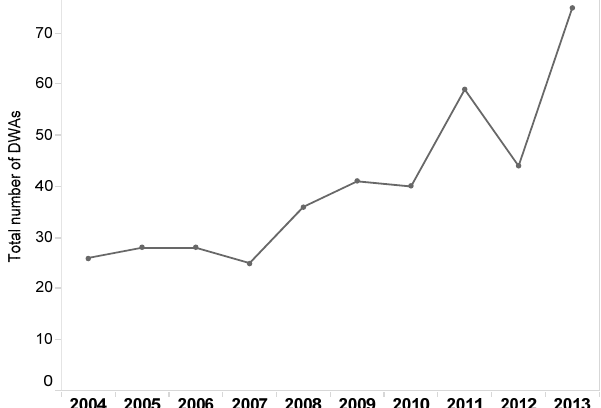
Figure 2. Annual trends in DWAs in First Nations drinking water systems in Ontario, 2004–2013. Table 2. Monthly and seasonal counts of DWAs issued in First Nations community drinking water systems in Ontario, 2004–2013.